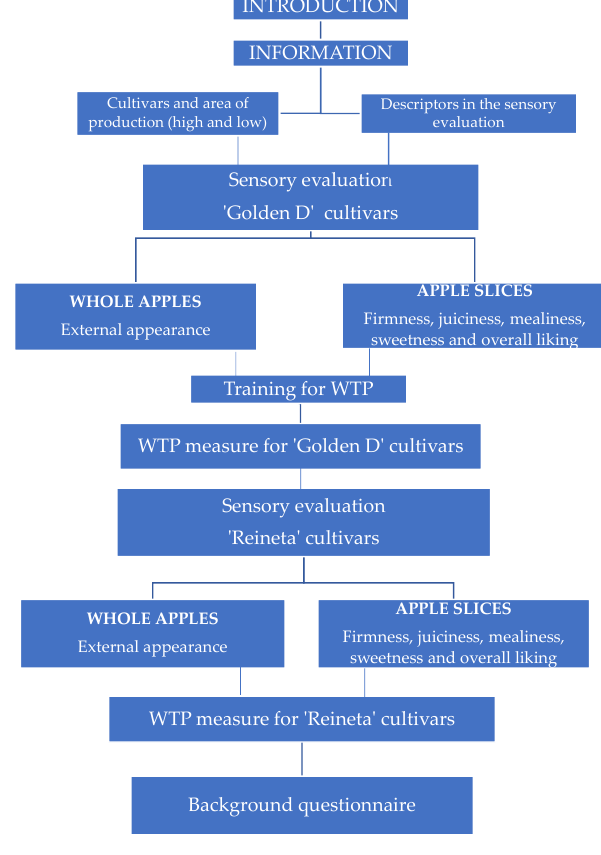
Figure 2. Flowchart of the experiment.